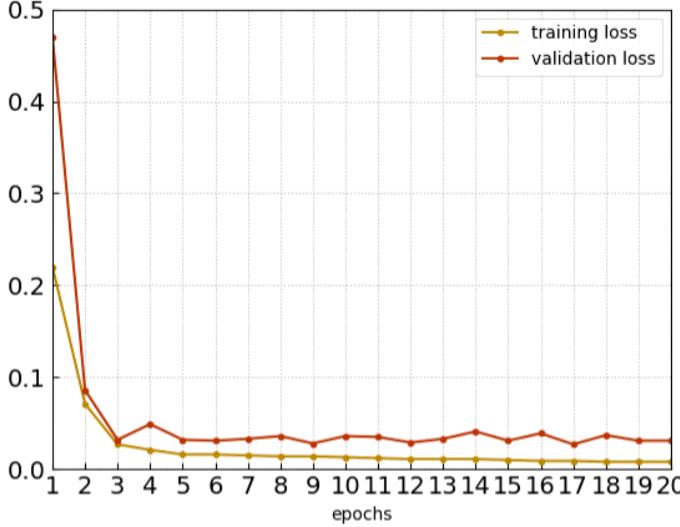
Figure 7. The loss curve of training procedure. Table 1. Classification accuracy (%) comparison on different scales with different